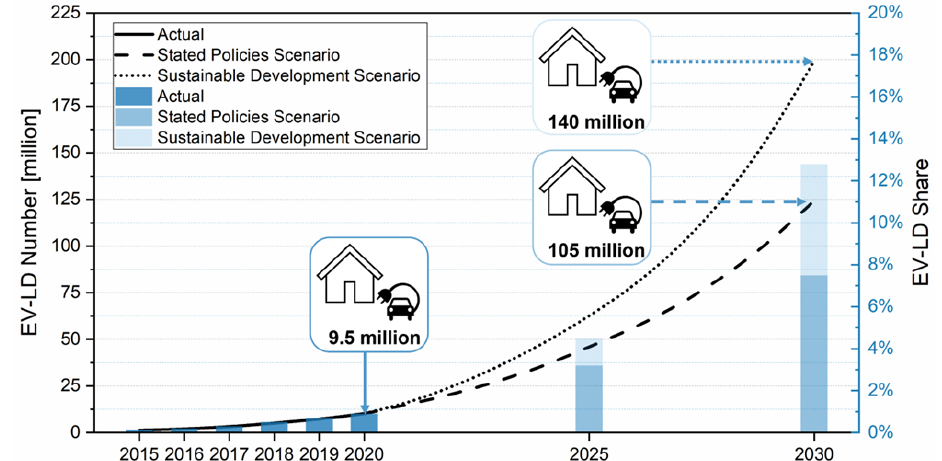
Figure 1. Electric Vehicle historical and prospective worldwide data. Line chart: number of electric light duty vehicles. Bar chart: share of electric light duty vehicle stock on total transport sector. Outlined box: number of private electric chargers.